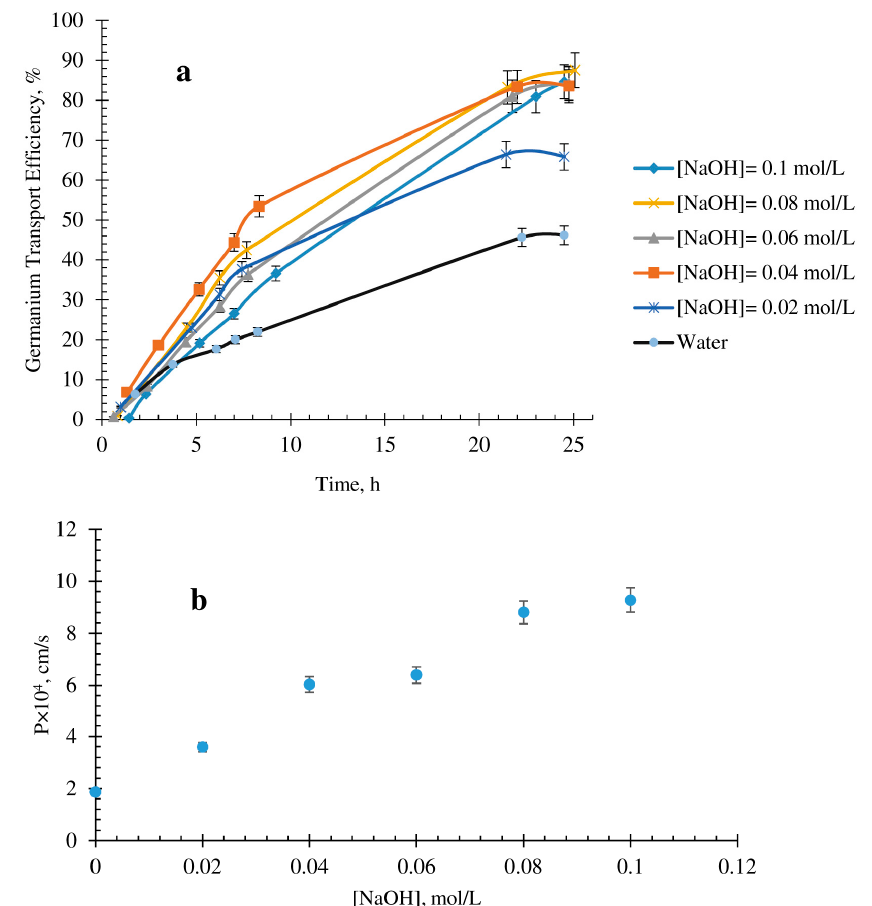
Figure 5. E ff ect of NaOH concentration on ( a ) transport and ( b ) permeability coe ffi cient of germanium on the FSSLM system ([Oxalic acid] = 0.075 mol / L, temperature of 22 ◦ C, and [Cyanex 923] = 20% v / Figure 5. Effect of NaOH concentration on ( a ) transport and ( b ) permeability coefficient of germanium on the FSSLM system ([Oxalic acid] = 0.075 mol/L, temperature of 22 °C, and [Cyanex 923] = 20% v/v).